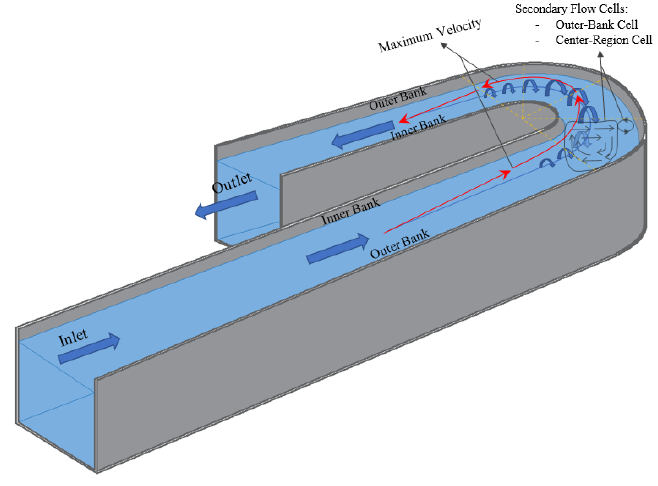
Figure 1. Flow pattern in a curved channel .